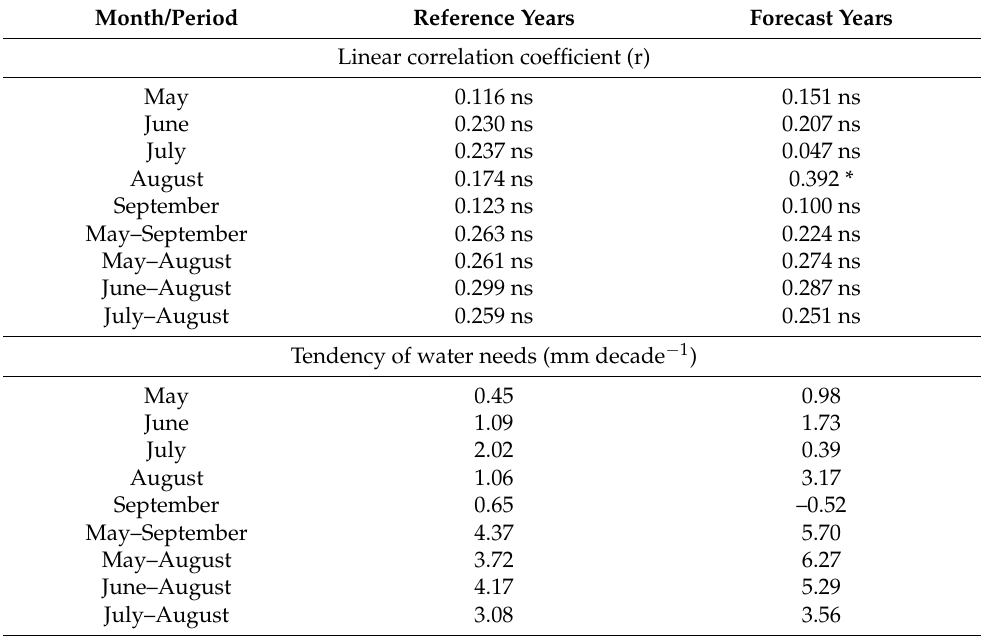
Table 3. The significance of the equations of trends in water needs of grapevines and their tendencies in the reference years (1981–2010) and forecast years (2021–2050).